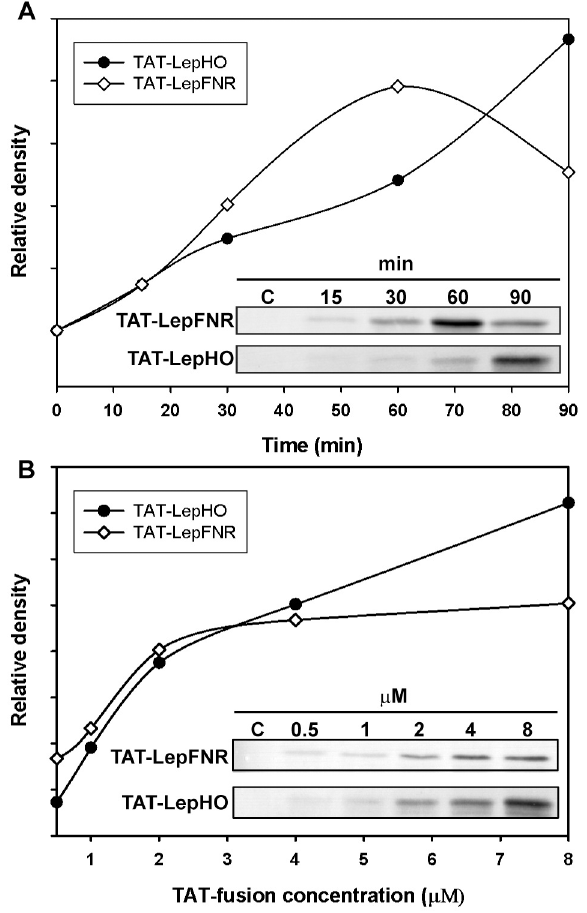
Fig 3. Transduction of TAT-LepFNR and TAT-LepHO into SH-SY5Y cells. (A) Transduction time dependence. SH-SY5Y cells were incubatedwith 1 μ M TAT-LepFNR (white diamonds)or TAT-LepHO (black circles) in serum free medium. Cell extracts were preparedat different time intervals and examinedby Western blot analysis. As a control, cells were incubatedfor 1 h with 1 μ M Lep-FNR/Lep-HO. (B)